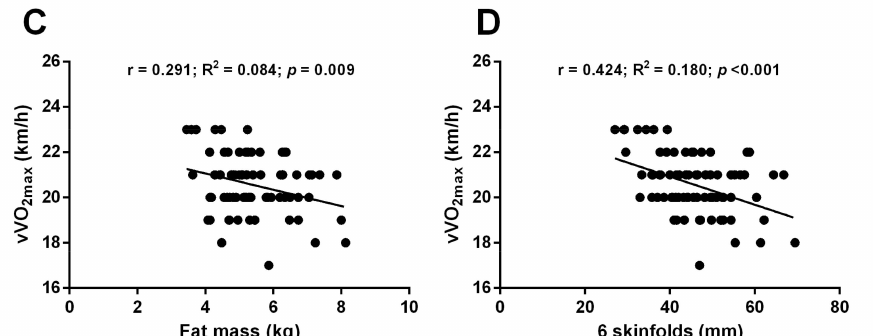
Figure 2. Linear regressions of significant correlations between performance parameters and an- thropometric values. ( A ): linear regression between fat mass and VO 2max ; ( B ): linear regression between ∑ 6 skinfolds and VO 2max ; ( C ): linear regression between fat mass and vVO 2max ; ( D ): linear regression between ∑ 6 skinfolds and vVO 2max ; r: Pearson’s coefficient of correlation; R 2 : coefficient of determination; p : p -value; VO 2 max: maximal oxygen consumption; vVO 2 max: running speed at maximal oxygen